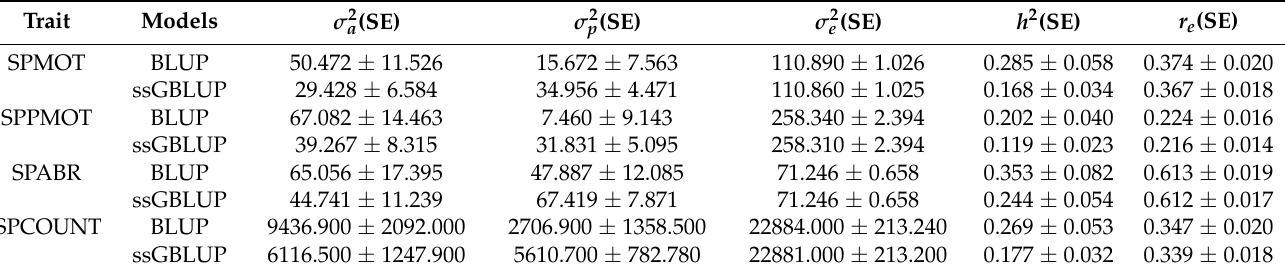
Table 2. Genetic parameters for the semen traits of Duroc pigs.